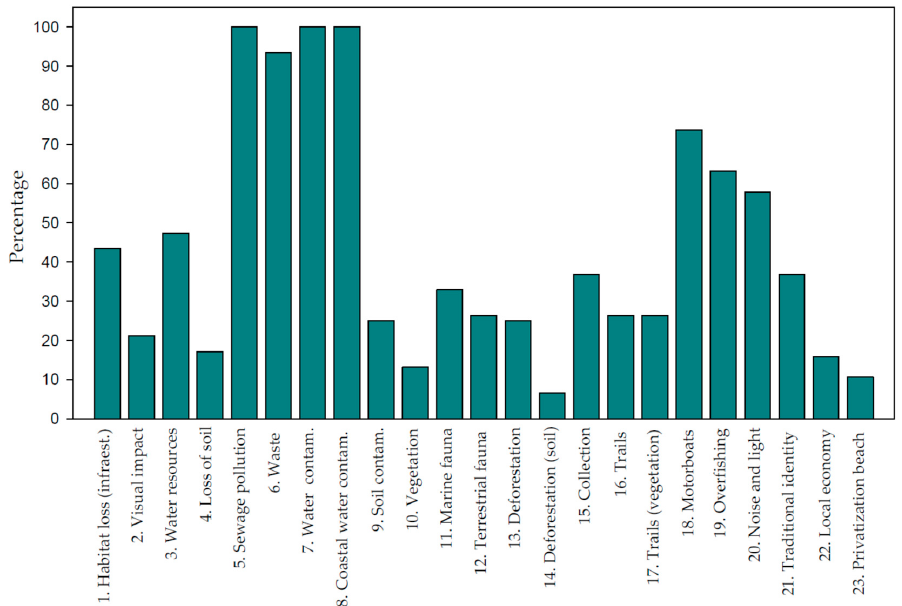
Figure 3. Percentage of participants that perceived each negative impact in the three national parks studied (the rest of the participants did not perceive the impact). Numbered impacts explained in Table 5.